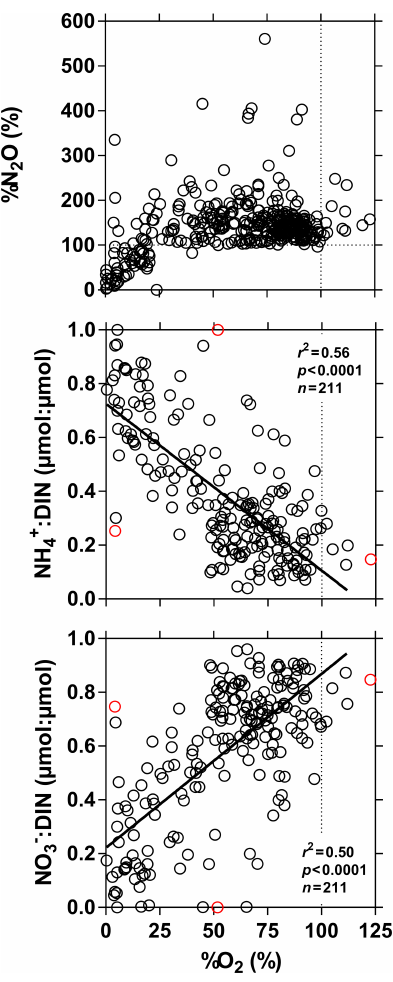
Figure 7. Dissolved N 2 O saturation level (%N 2 O in %), ratio of + NO − + NO − NH + to dissolved inorganic nitrogen (DIN = NH + ) 4 4 2 3 (µmol:µmol) and ratio of NO − to DIN (µmol:µmol) in surface wa- 3 ters of the Congo River network as a function of dissolved O 2 sat- uration level (%O 2 in %). Outliers (red dots) were identified with a Cook’s distance procedure and removed prior to linear regression analysis (solid line).